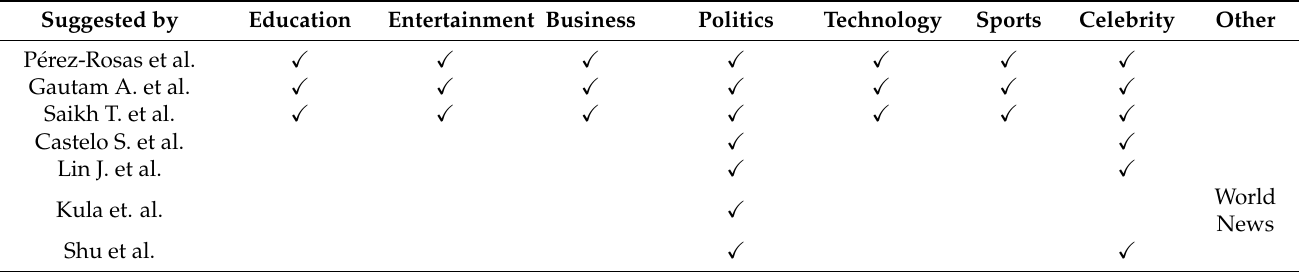
Table 6. Domains Covered by Cross-Domain Methodologies.